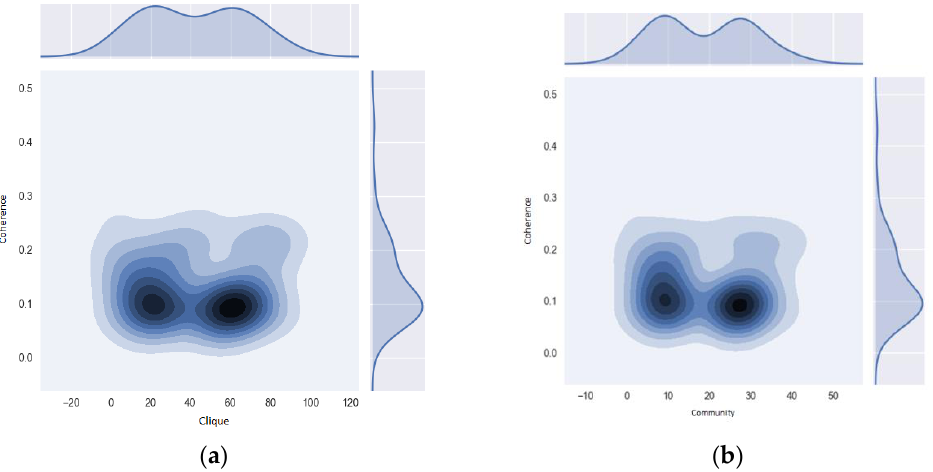
Figure 10. Nodal degree and nodal strength for the SISBEN I and II population resident in the Risaralda province. Complementary cumulative distribution functions of ( a ) the nodal degree K , and ( b ) the nodal strength, 𝐹 𝐾 for the Morbidity Network of Diagnoses of the SISBEN I and II population, residing in the Risaralda province, from 2011 to 2016. Source: authors’ own calculations.